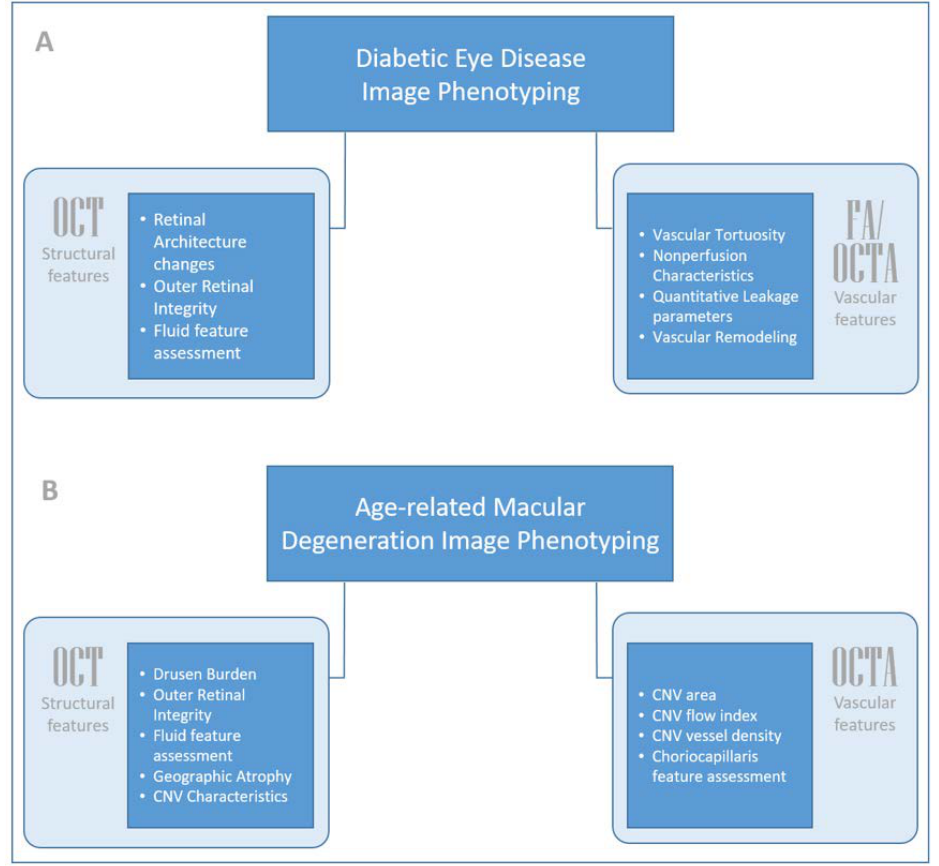
Figure 1. Schematic summarizing changes in various quantitative imaging biomarkers in ( A ) diabetic eye disease and ( B ) age-related macular degeneration. CNV: choroidal neovascularization . Review Methodology. A literature search was performed using the key words “quan- titative imaging”, “diabetic retinopathy”, “age related macular degeneration”, “OCT”,